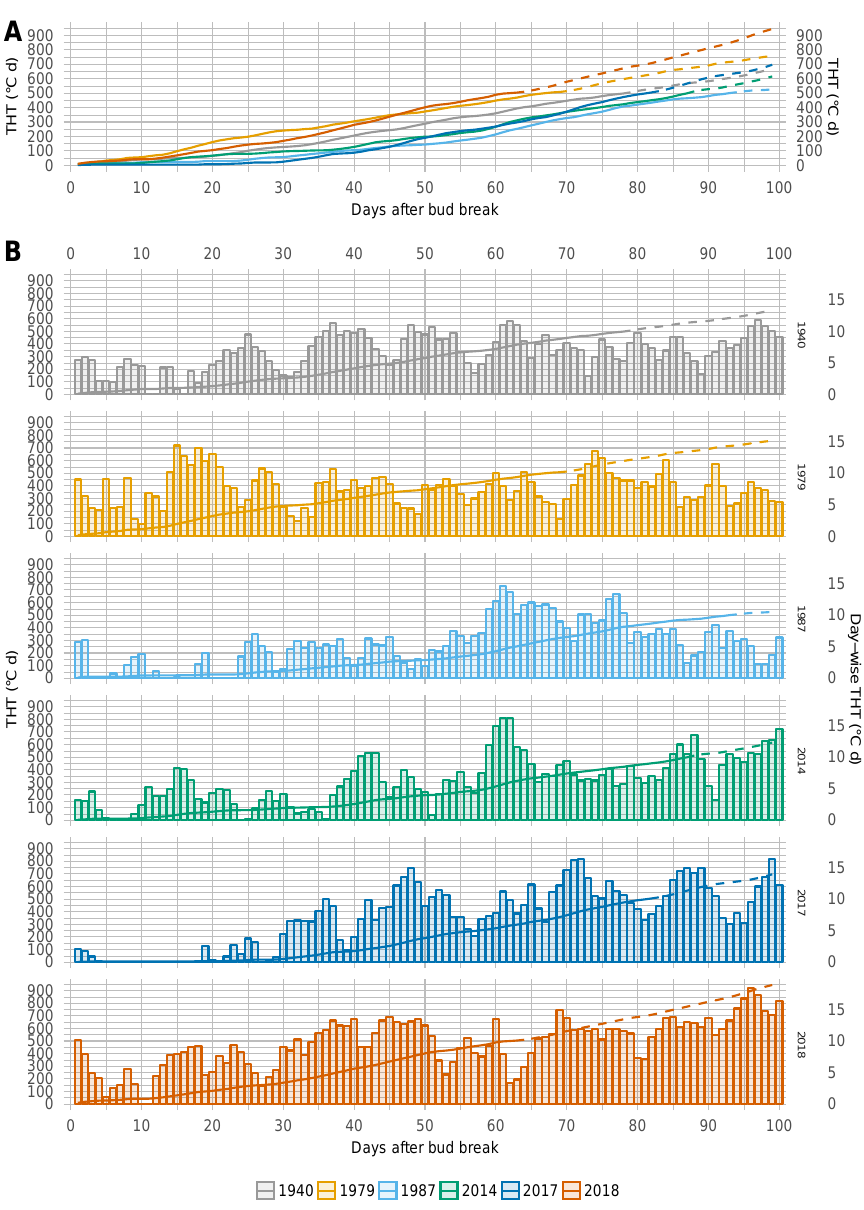
Figure 11. Thermal time (THT) development for simulations years: ( A ) direct comparison of thermal time (sum); and ( B ) year-wise plots including daily THT contributions. Start of dashed lines indicates average end of simulation date per